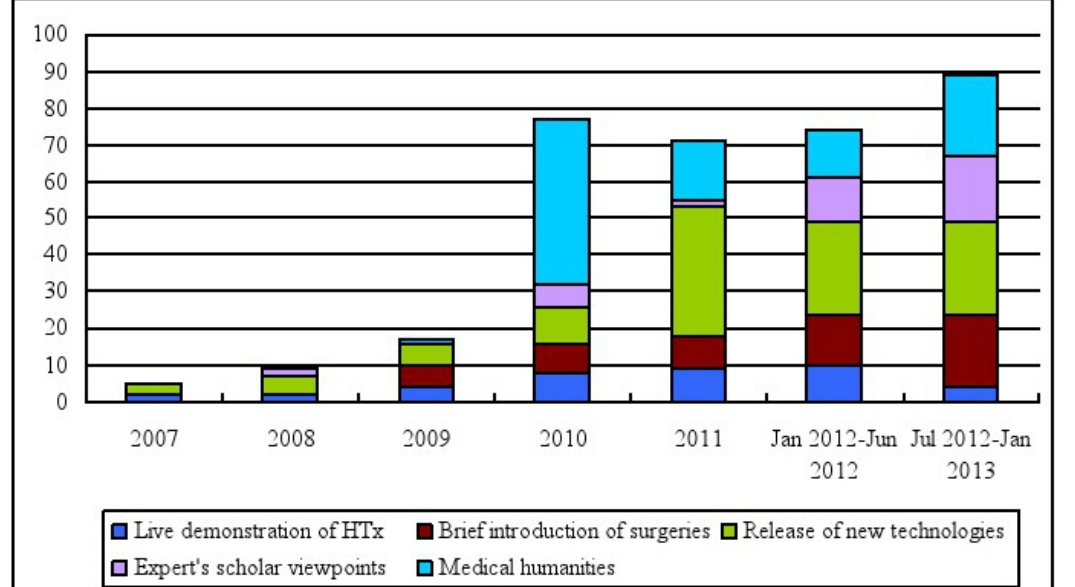
Figure 2. The annual numbers of useful HTx-related